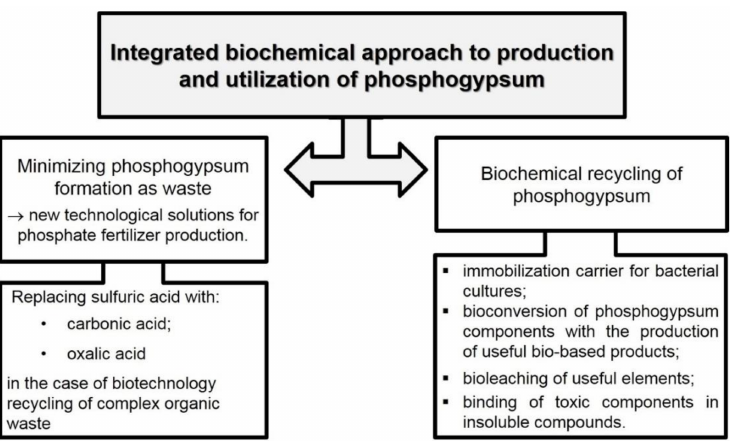
Figure 9. An integrated biochemical approach to production and utilization of